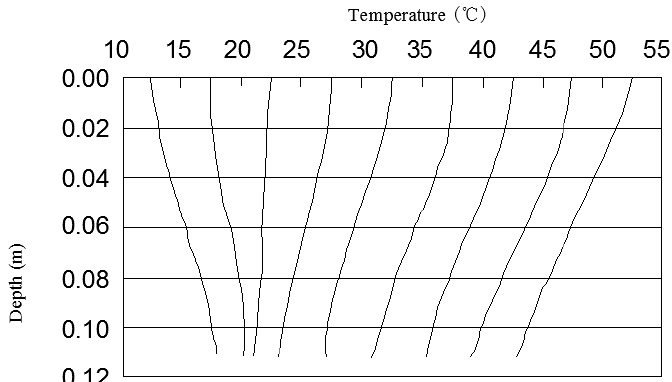
Figure 8. Calculated temperature in the asphalt pavement structure.